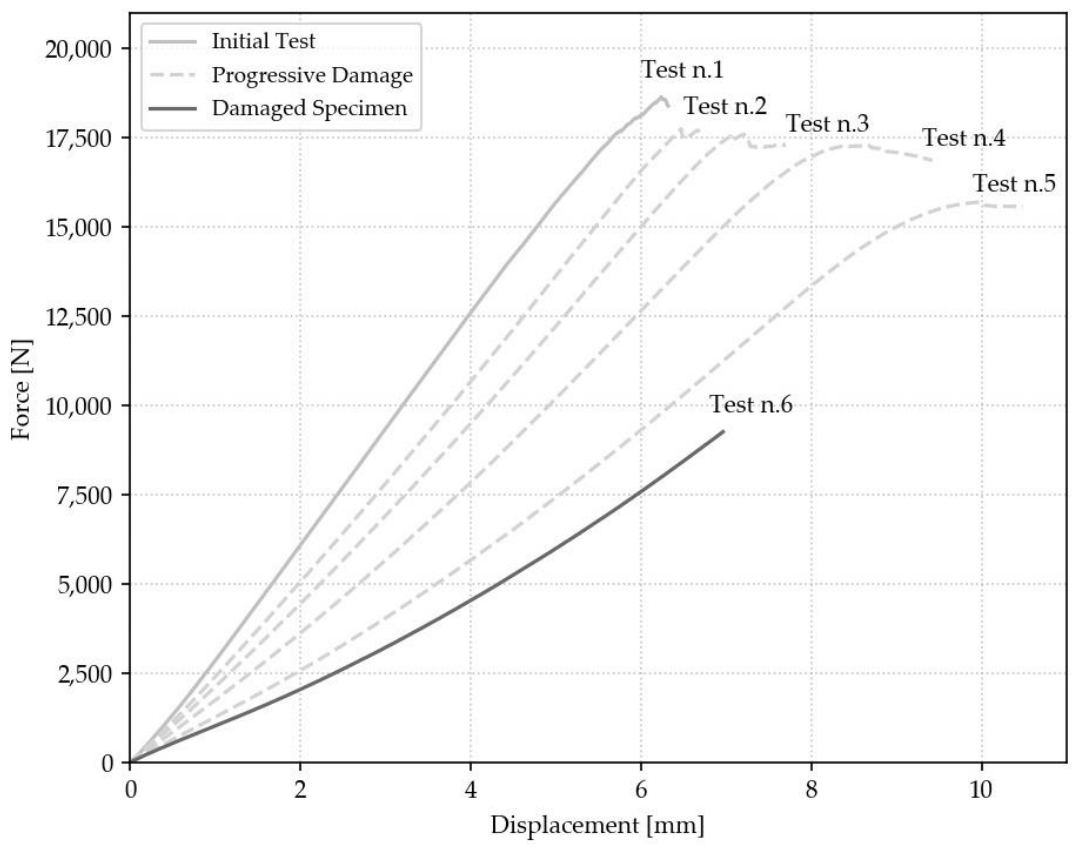
Figure 5. Progressive damaging of composite plate through four-point bending tests.